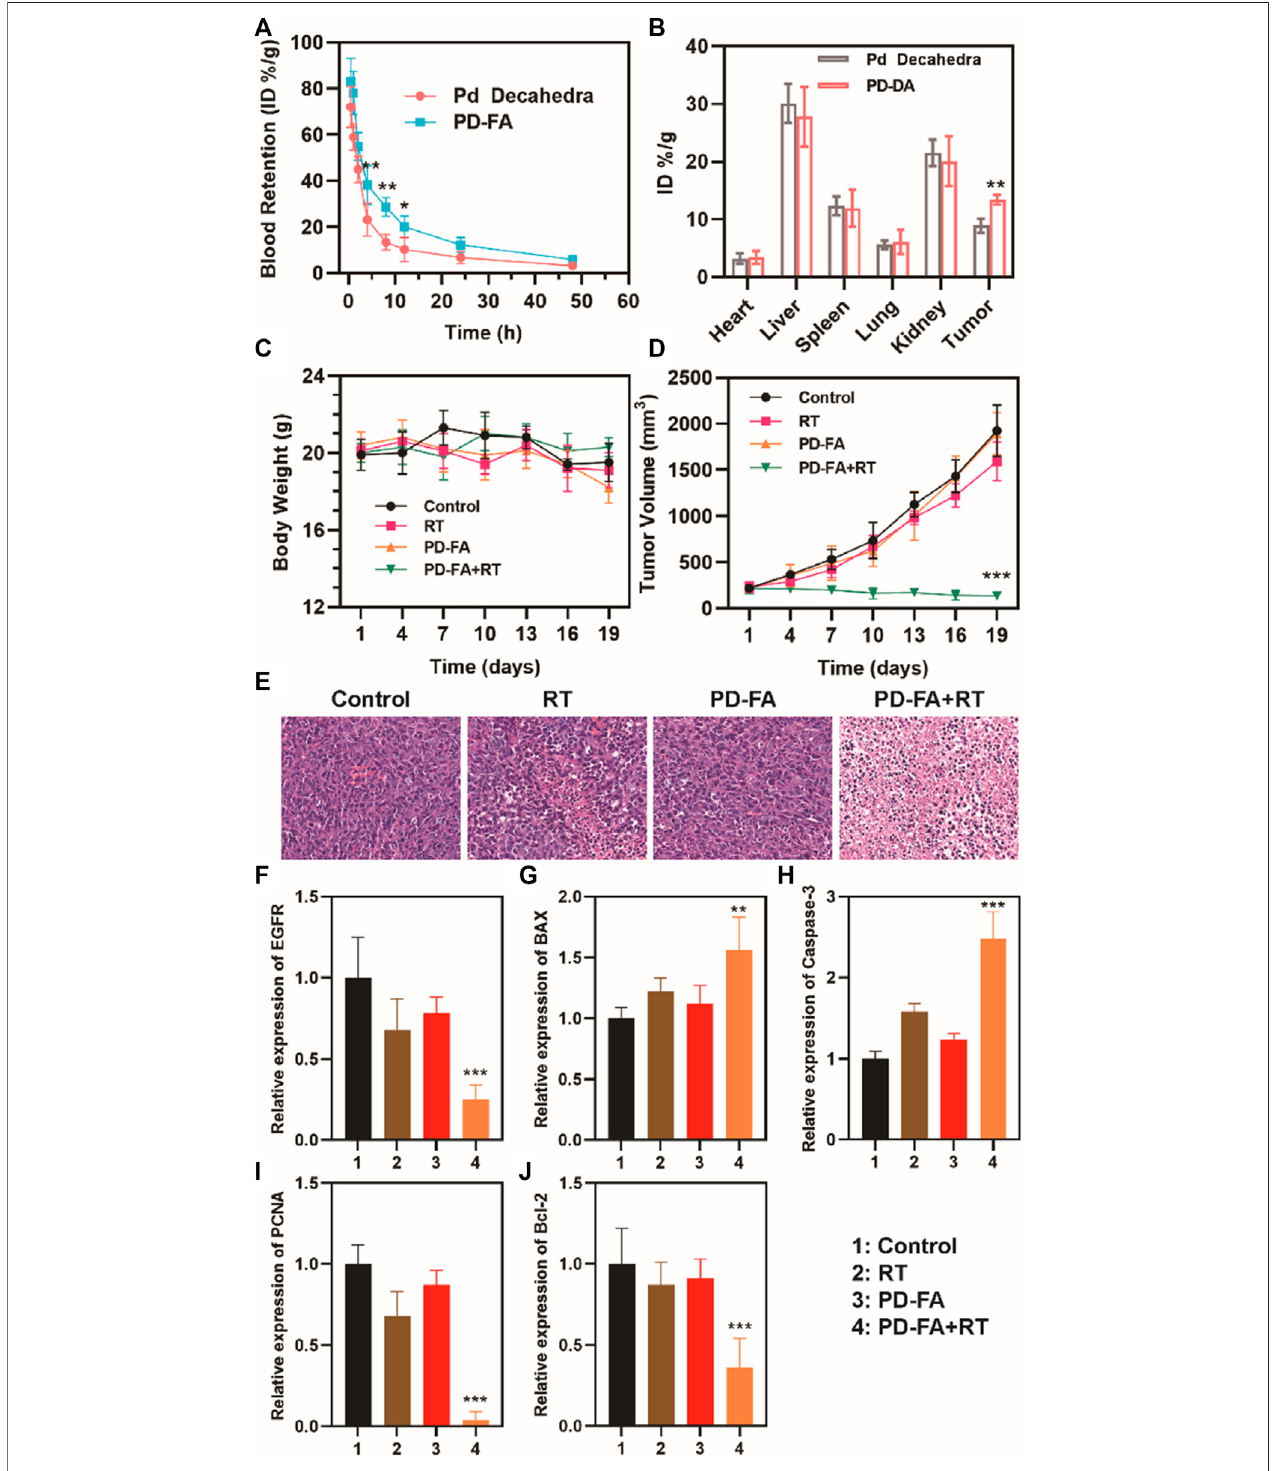
FIGURE 4 | Analysis of antitumor ef fi cacy. (A) Pharmacokinetic curves. (B) Biodistribution results for the indicated treatment groups. (C) Murine body weight and (D) tumor volumes in the four treatment groups. (E) HE staning of tumors in four groups. Quantitative analyses of the expression of (F) EGFR, (G) BAX, (H) Caspase-3, (I) PCNA, and (J) Bcl-2 in the indicated groups as assessed via RT-PCR.